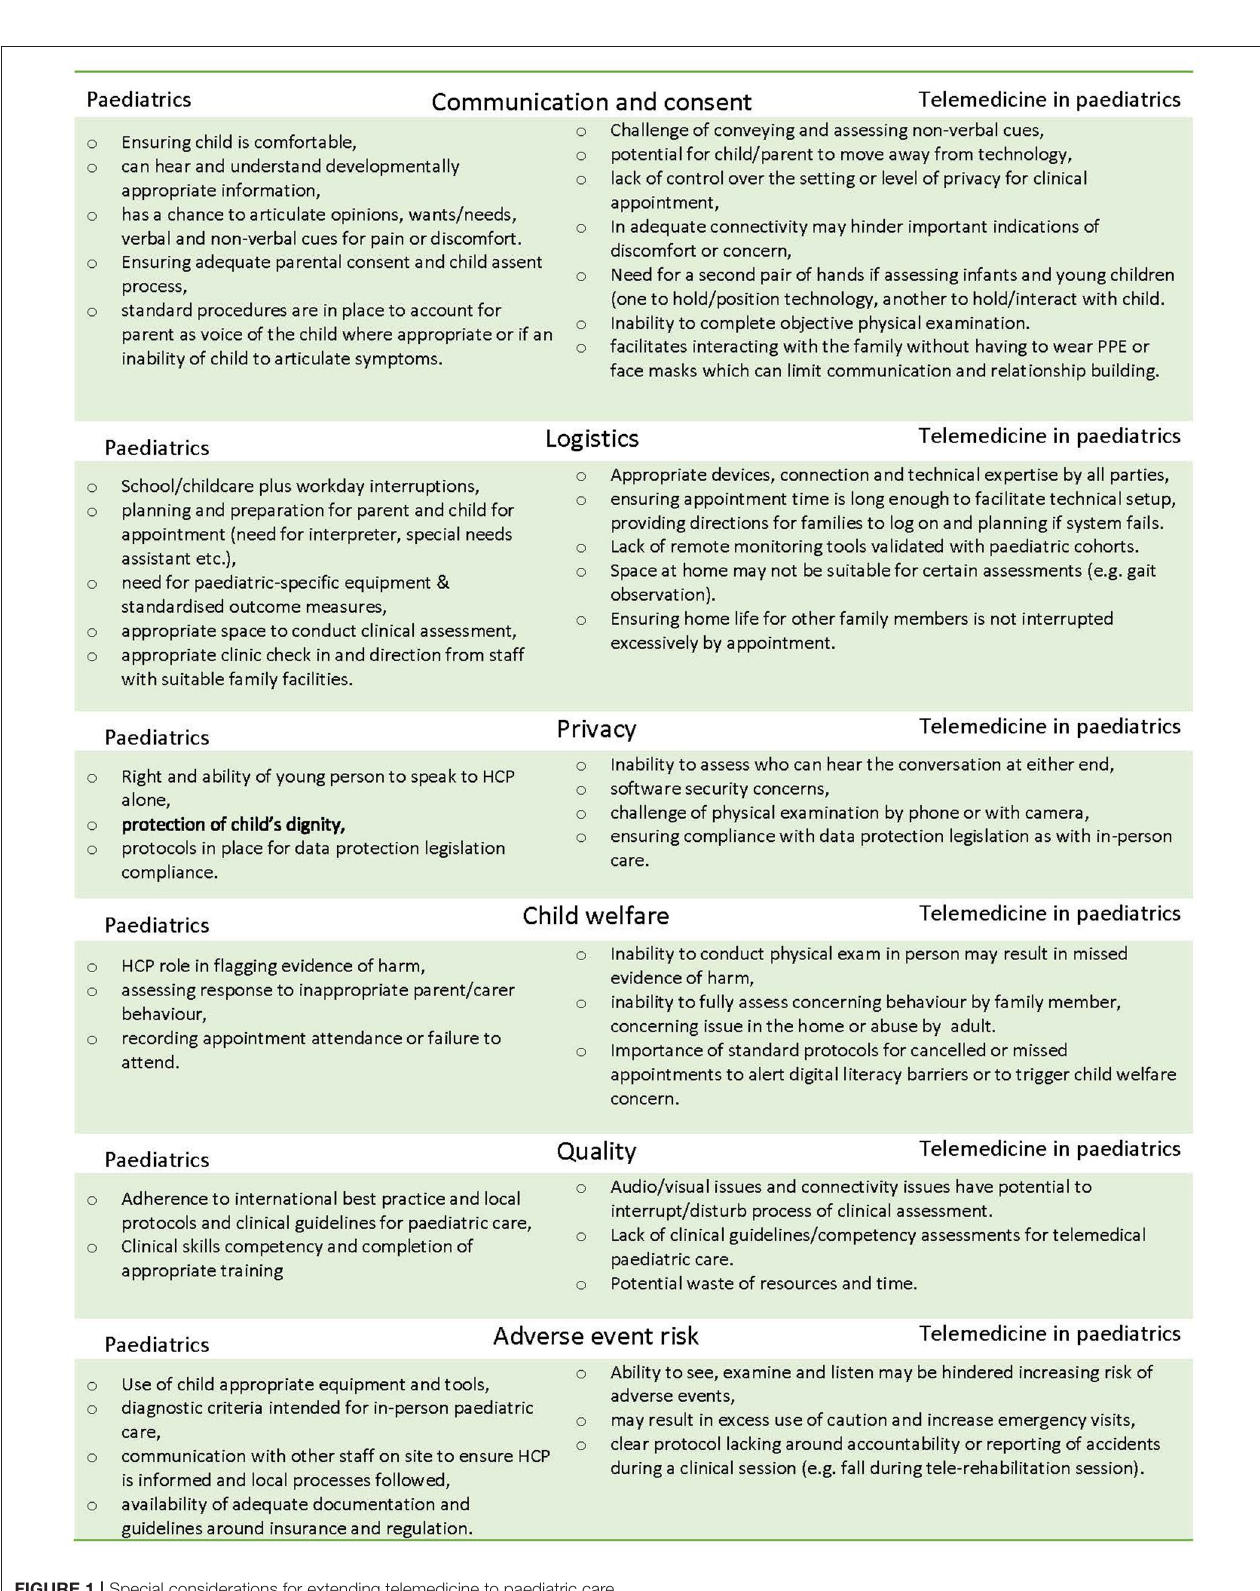
Frontiers in Pediatrics |